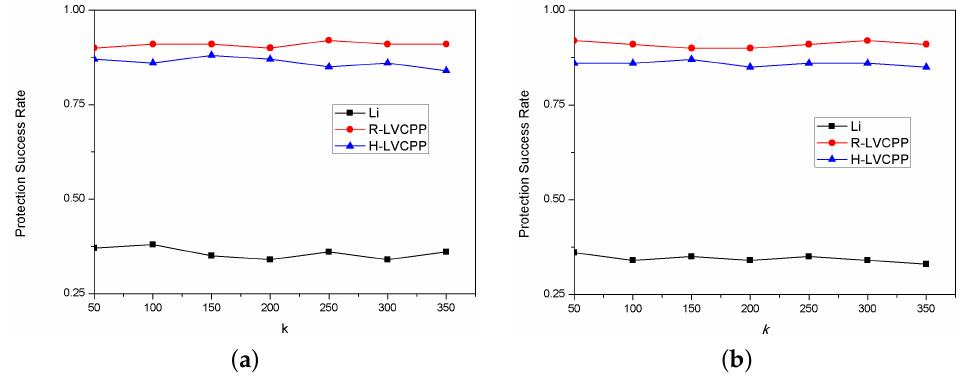
Figure 9. Protection success rate evaluation under different k : ( a ) Brightkite; ( b )